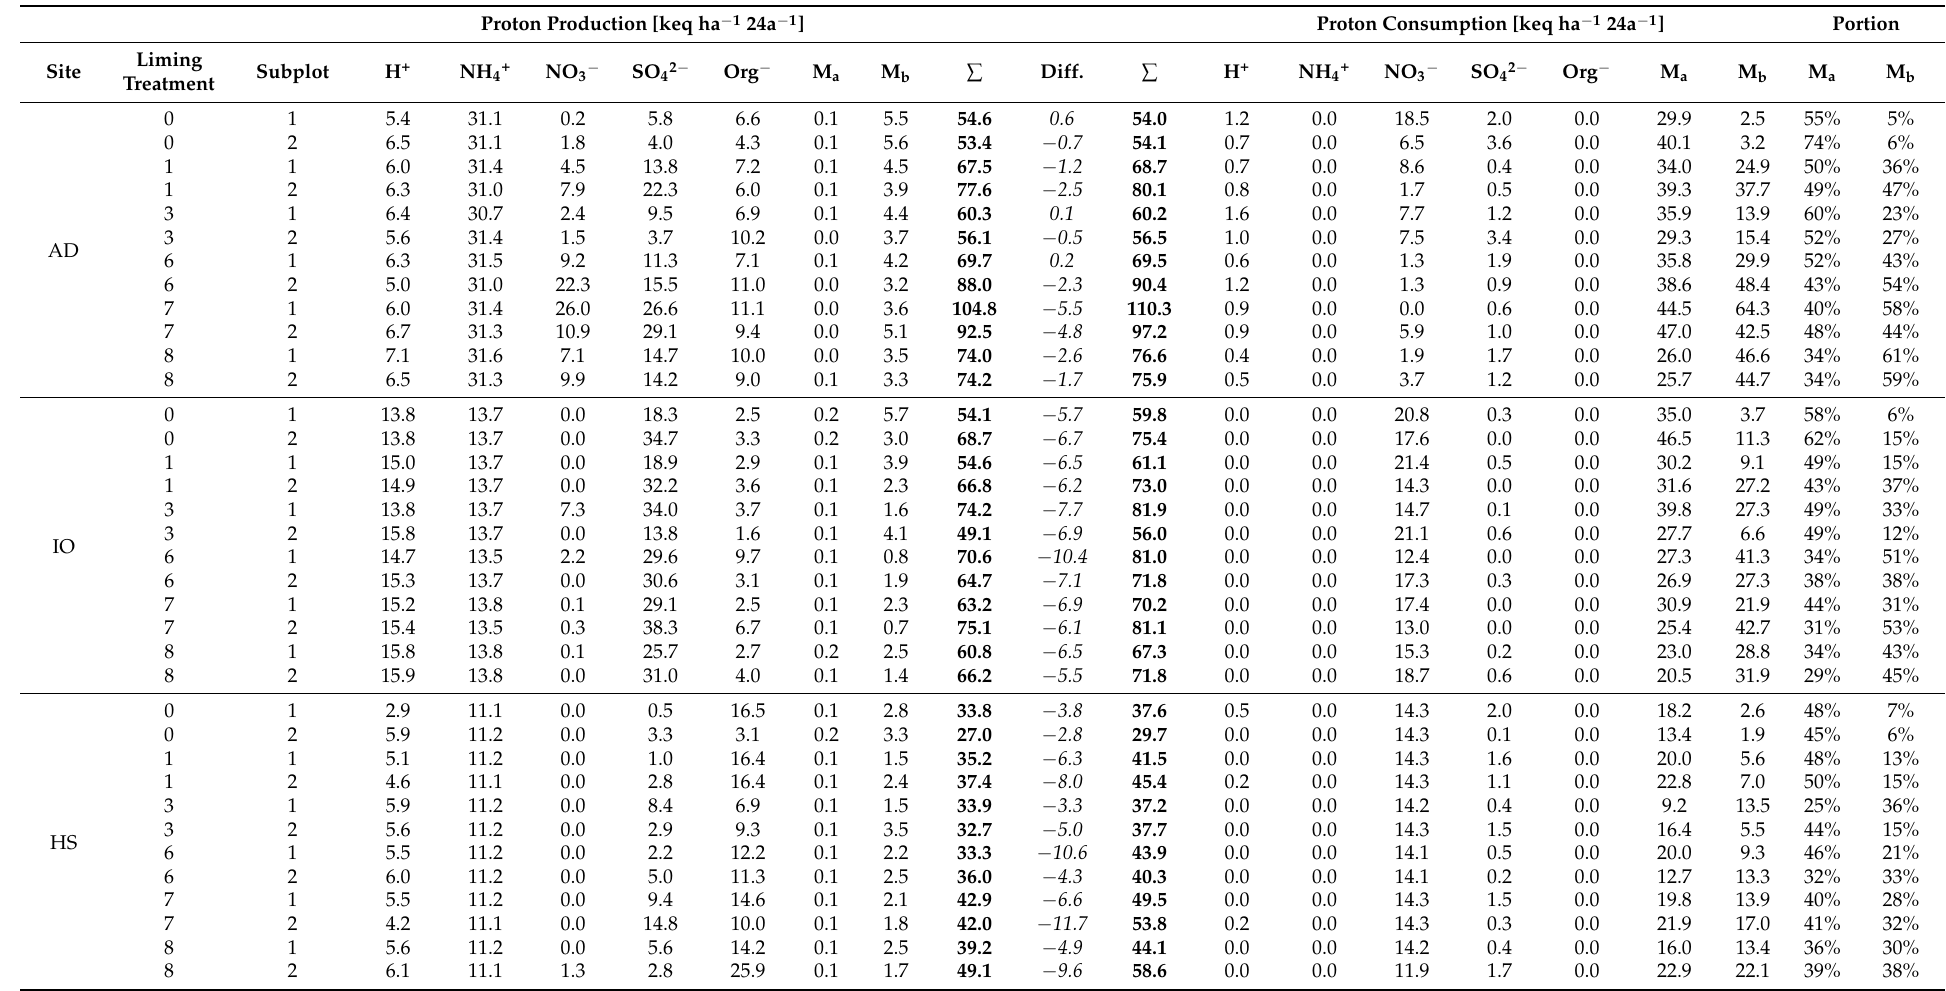
Table 3. Total proton production and proton consumption by the different element budgets accumulated over 24 years (1989 to 2012) for the control subplots and liming treatments of the three experimental